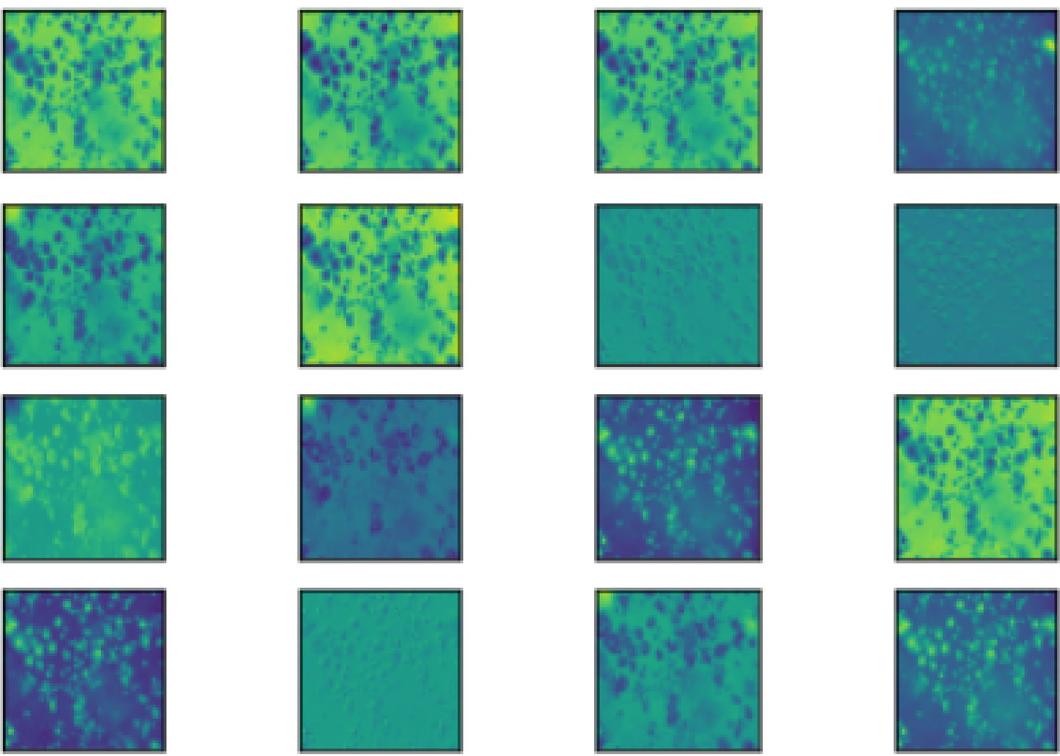
Figure 12. Visualization of the convolution filters of the Inception v3 model on the Mendeley LBC dataset (the plots have been formed using Keras framework of